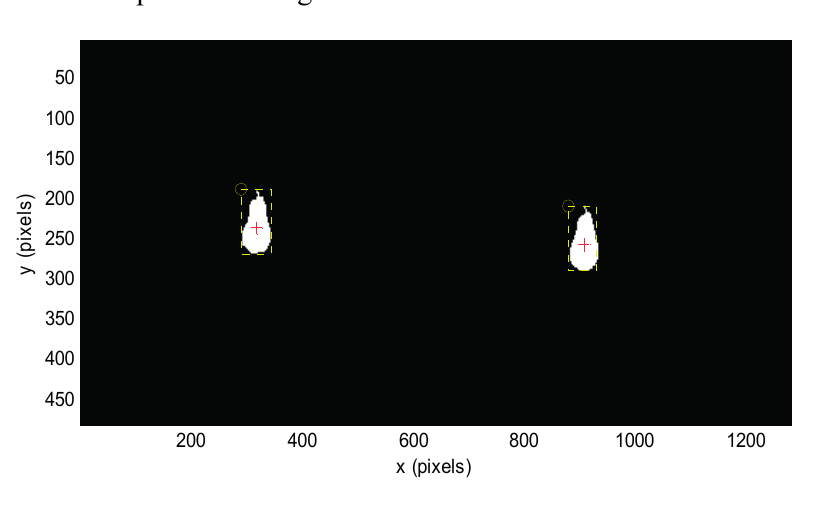
Figure 11. Example of fruit segmentation and location in a stereovision